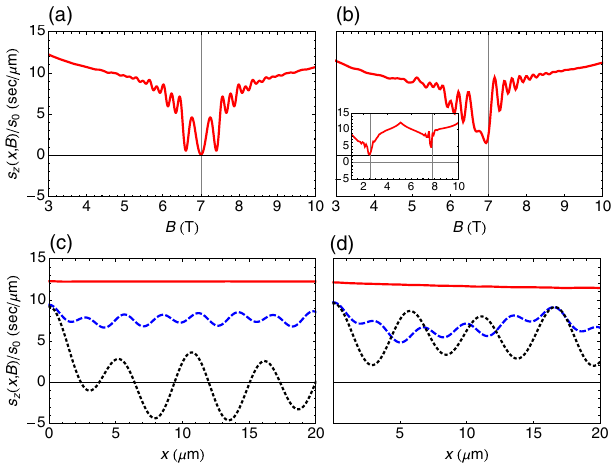
FIG. 4. Ratio of adjacent energy level splitting due to SO interaction to the total energy level splitting for pairs of propagating modes, R ¼ jh n; γ j ˆ s jh n; γ j ˆ s z j n; − γ ij 2 Þ . Parameters are chosen so that B resonant ¼ 7 hand panel shows R for parabolic confinement; the right-hand panel shows R for square-well confinement. B ¼ 3 T (solid red line), (dotted black line).